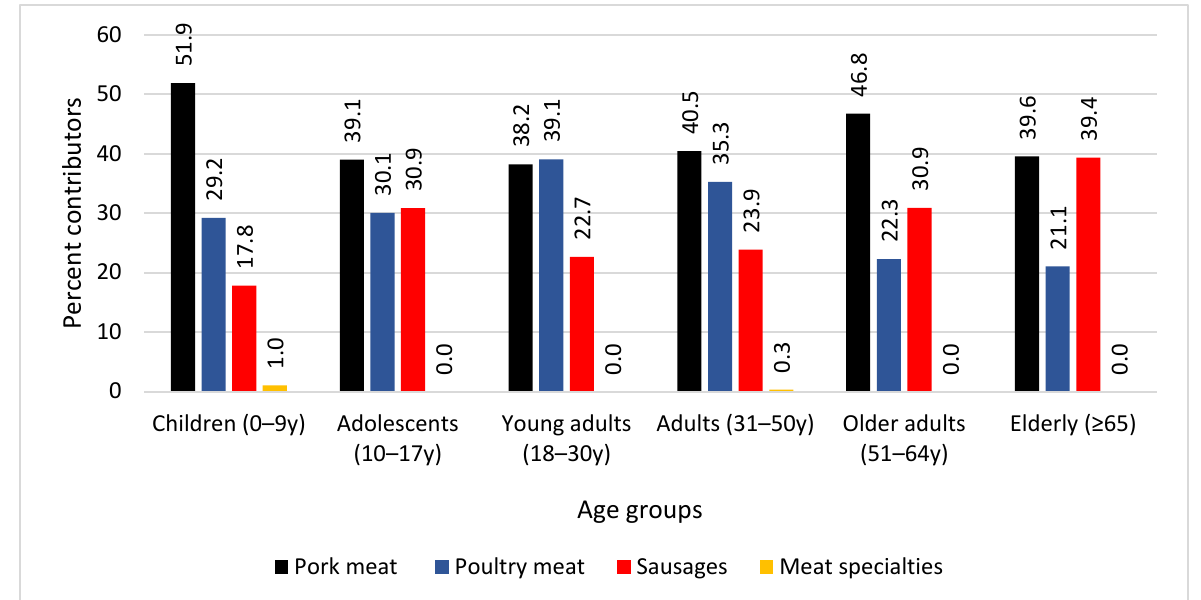
Figure 3. Main processed meat food groups contributing to total nitrite intake among consumers of the same age group.